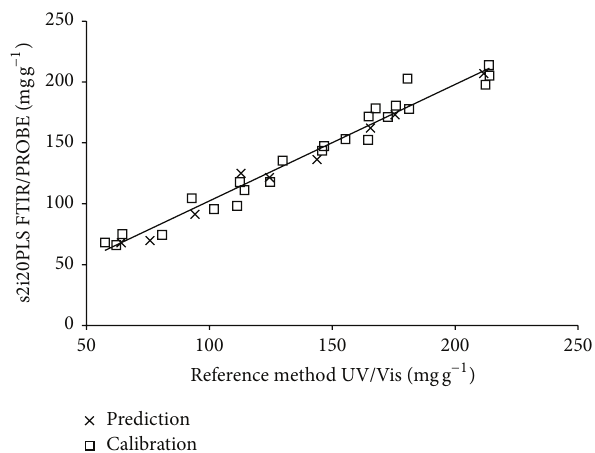
Figure 3: Calibration curve obtained using best model